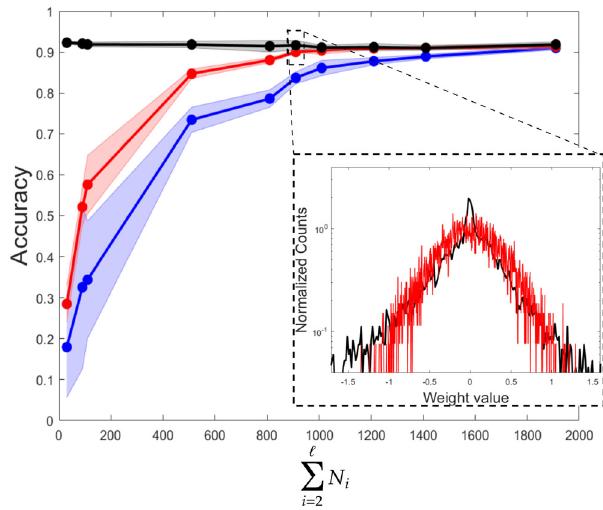
Fig. 6 Deep linear scheme. The performance of the spectral algorithm is tested for a multilayered linear con fi guration. Symbols are chosen in analogy to Fig. 5. In all cases, the input layer is made of N 1 = 784 elements and the output layer has N ℓ = 10 nodes. The fi rst fi ve points, from left to right in each of the curves depicted in the main panel, refer to a three layers (linear) neural network. The size of the intermediate layer is progressively increased, as N 2 = 20, 80, 100, 500, 800. The total number of trained eigenvalues is N 2 + N 3 . The subsequent four points are obtained by considering a four layers architecture. In particular, N 2 = 800 while N 3 takes values in the interval (100, 200, 400, 600). The training acts on N 2 + N + N fi nal point in each curve is obtained with a four 3 4 eigenvalues. The layers deep neural network. Here, N 2 = 800, N 3 = 600 and N 3 = 500, for a total of N 2 + N 3 + N 4 + N 5 tunable parameters in the spectral setting. Inset: the distribution of the entries of the equivalent perceptrons are displayed, with the same colour code adopted in Fig. 5. Also, in this case, the weights refer to the two-layers con fi guration obtained by retracting the intermediate linear layers employed in the learning